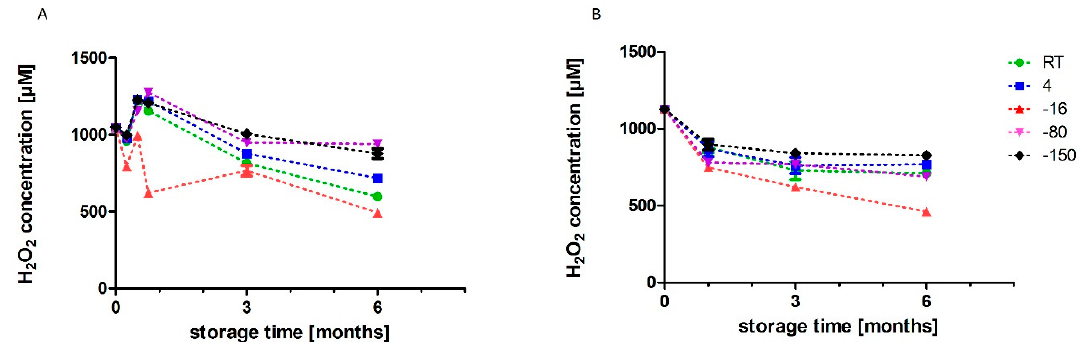
Figure 9. Hydrogen peroxide concentrations of PAW set 3 ( A ) and set 4 ( B ) stored at different temperatures for 6 months.